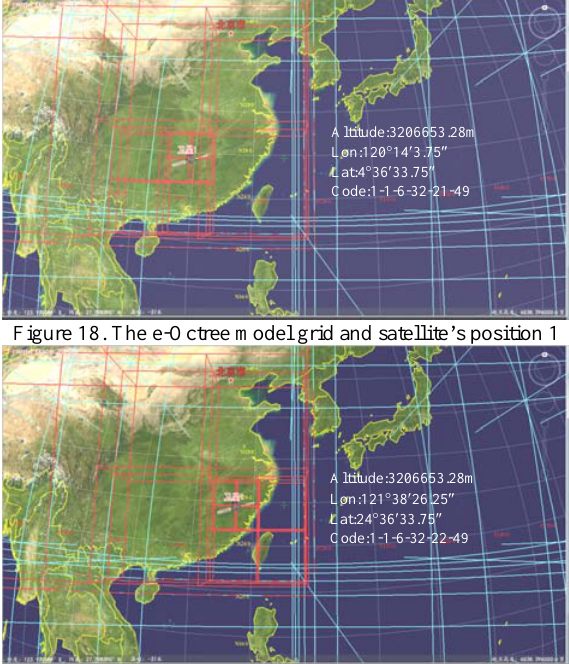
Figure 19. The e-Octree model grid and satellite’s position